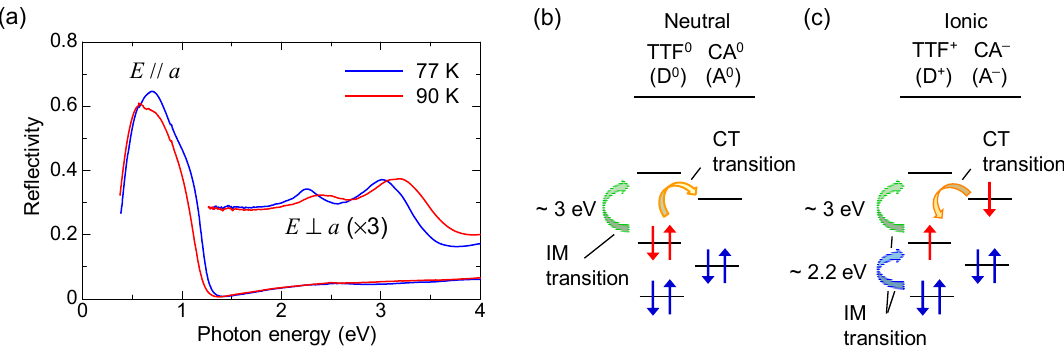
Figure 5. ( a ) Polarized reflectivity spectra at 90 K in the neutral phase and at 77K in the ionic phase of TTF-CA [19]; ( b , c ) Schematic of optical transitions in the neutral phase ( b ) and in the ionic phase ( c ).